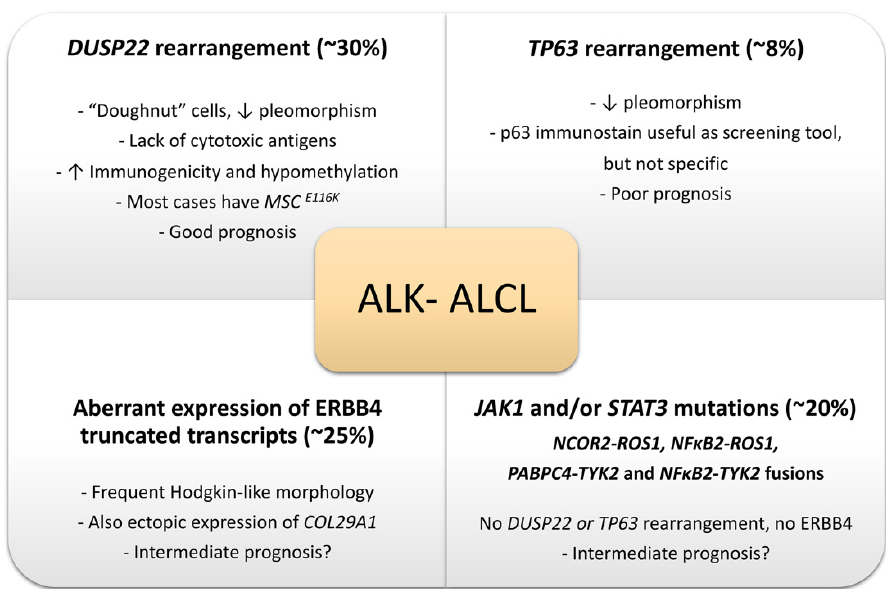
Figure 10. Relevant molecular alterations in systemic ALK- ALCL (see also